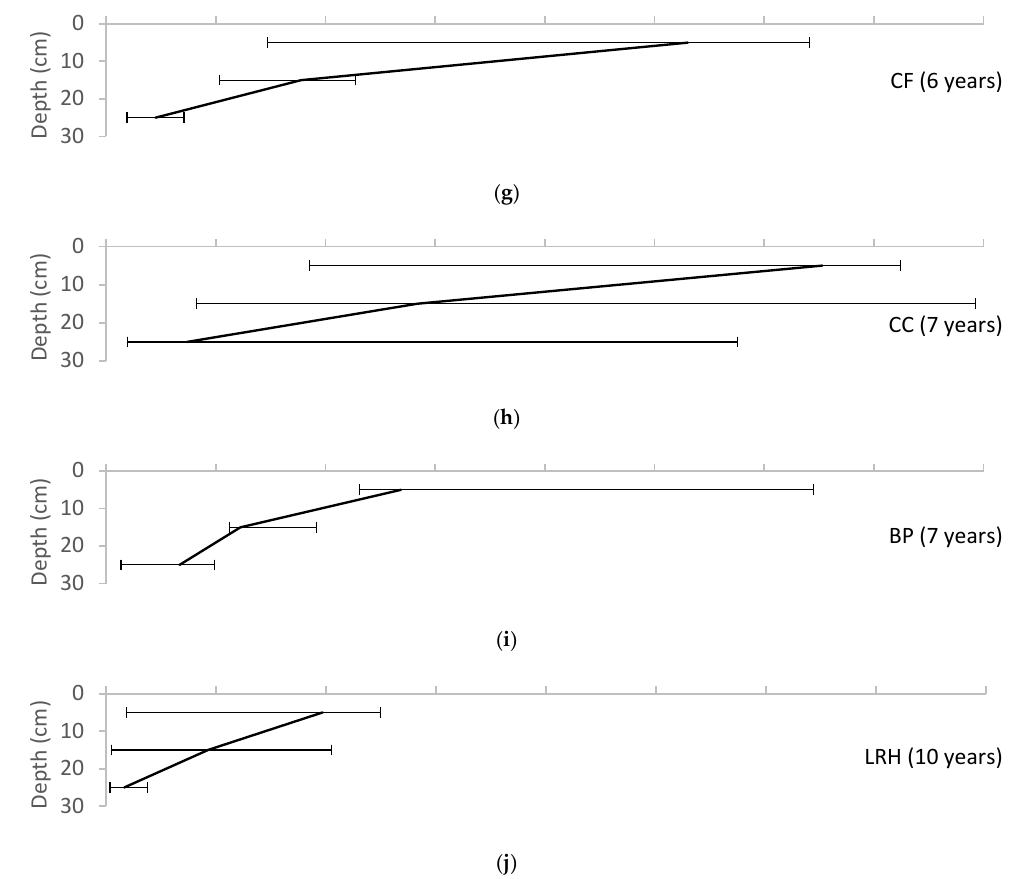
Figure 5. Variation of root biomass with depth for each of the field sites, reported as median ± range. ( a ) UMCP; ( b )WNY; ( c ) MJES; ( d ) CBF; ( e ) NWHS; ( f ) PP; ( g ) CF; ( h ) CC; ( i ) BP; ( j ) LRH.